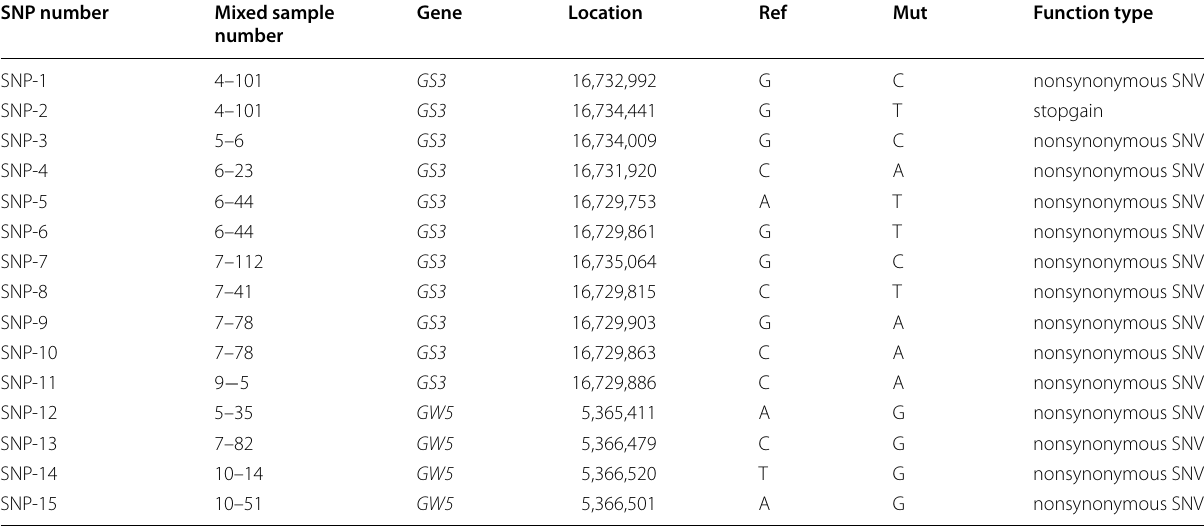
Table 2 Targeted sequencing mutation site information SNP